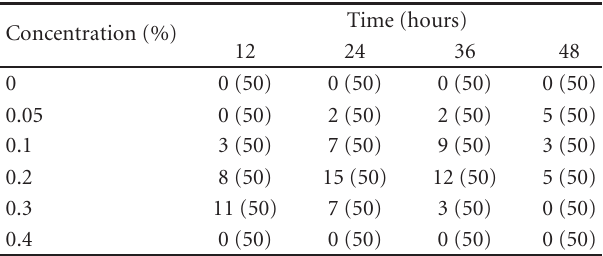
Table 1: E ff ect of direct application of colchicine solutions on the seeds of C. roseus and the number of tetraploid plants regenerated (50 seeds for each